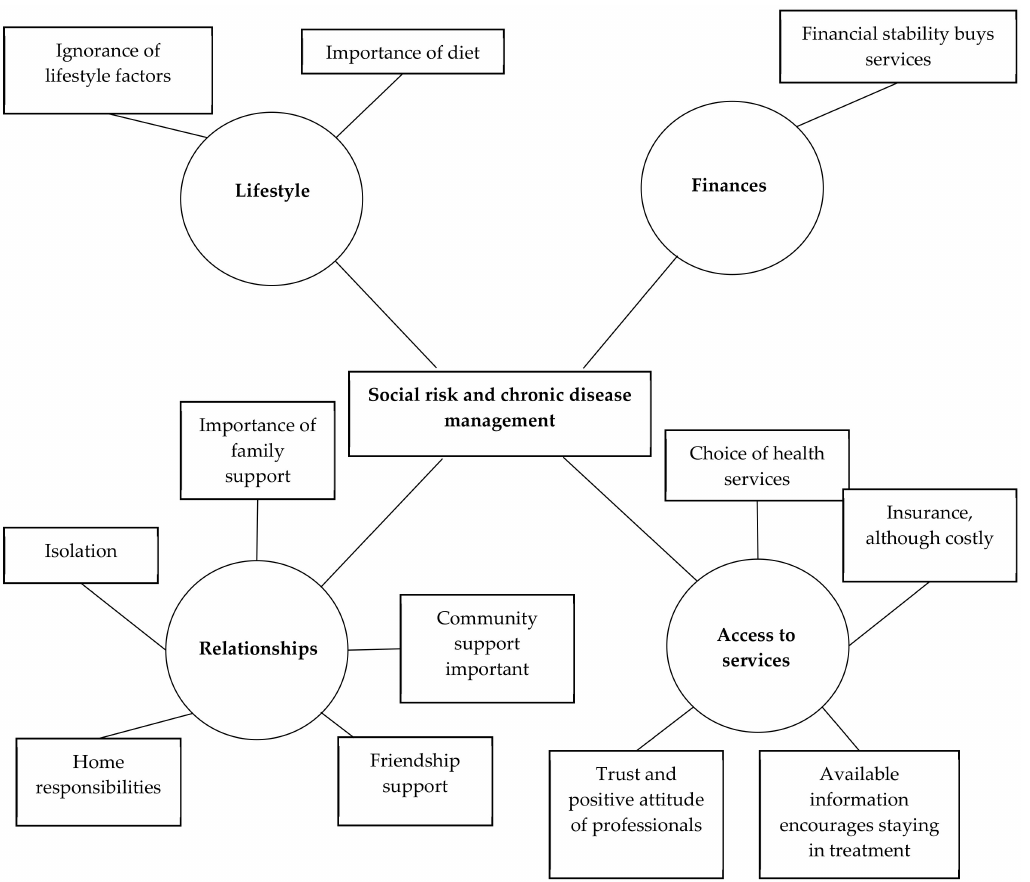
Figure 2. Thematic network: Low-Risk